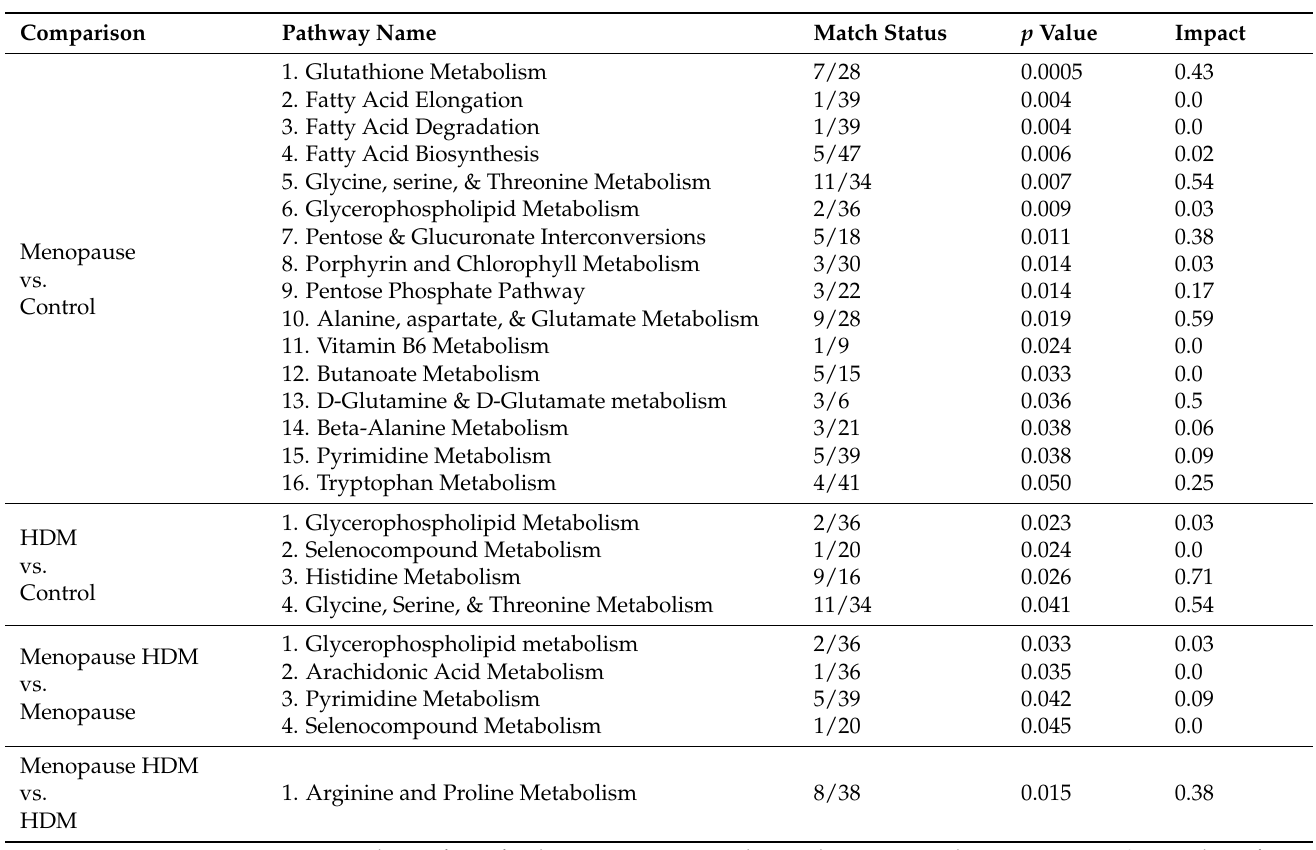
Table 4. Significantly impacted metabolic pathways in the